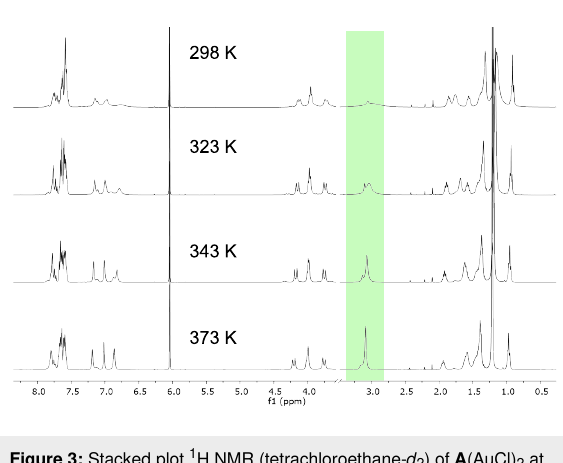
Figure 3: Stacked plot 1 H NMR (tetrachloroethane- d 2 ) of A (AuCl) 2 at variable temperature.